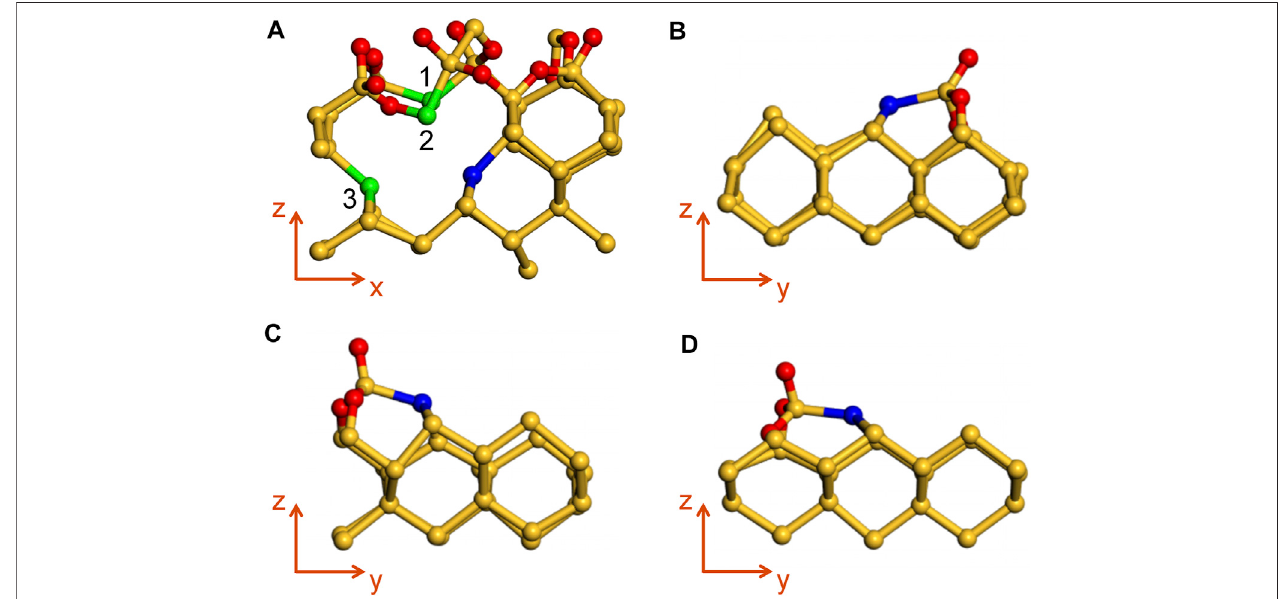
FIGURE 1 | (A) The schematic diagram of P b0 defect model. (B – D) P b1 defect models with AOD con fi guration at three randomly selected positions. Blue spheres indicatethelocationof P